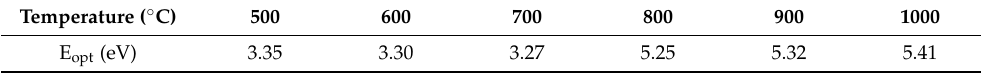
Table 4. Willemite NPs optical band gap at various calcination temperatures.